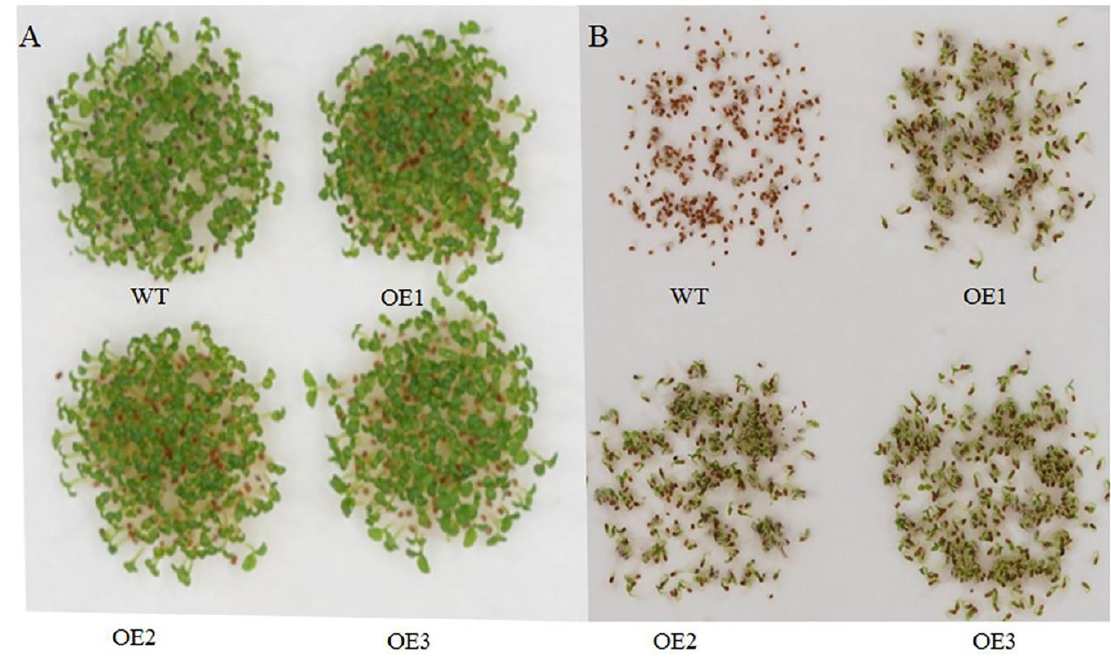
Figure 6. LK stress response of ApCPX1 transgenic tobacco lines. Note ( A ) Morphological observation of WT and transgenic lines under CK conditions; ( B ) Morphological observation under LK conditions. WT indicates non-transgenic tobacco; OE1, OE2, and OE3 indicate transgenic tobacco lines.